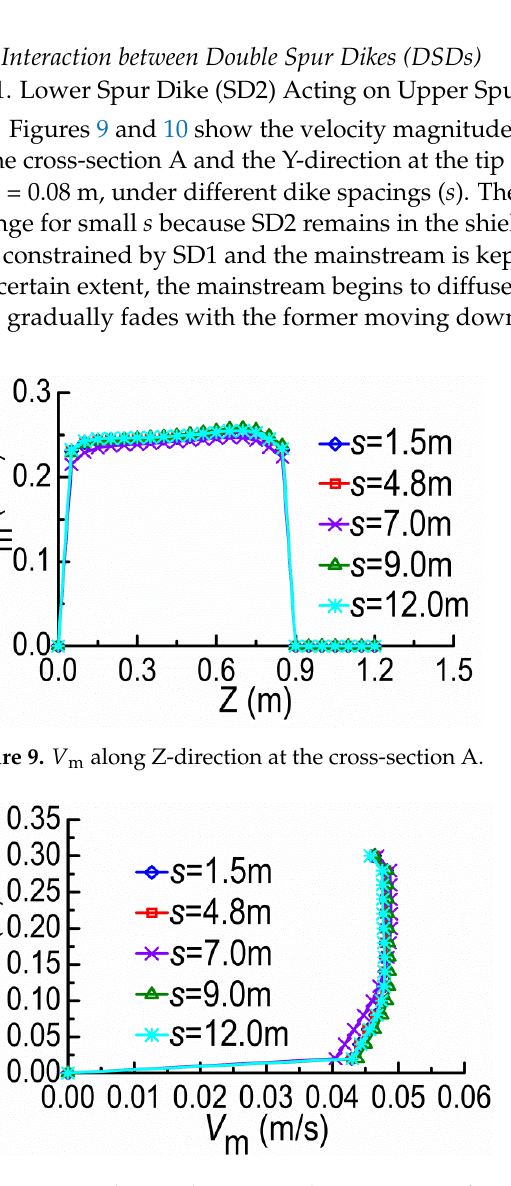
Figure 11. V m along Z-direction at the cross-section B.